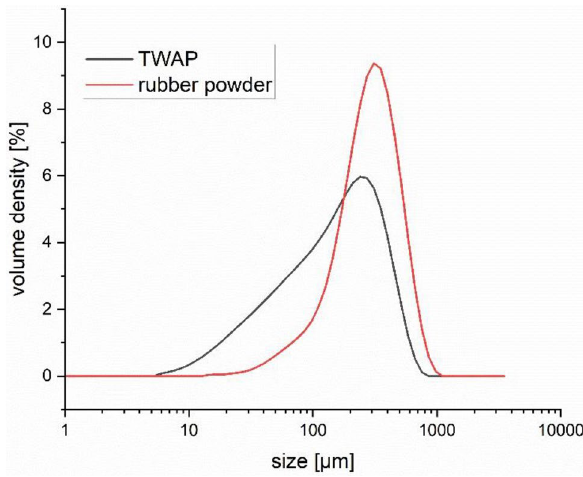
Figure 1. Particle size distribution of rubber powder and TWAP.